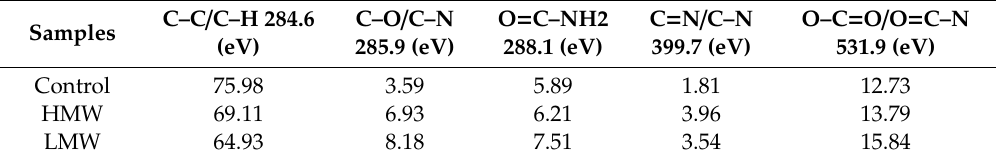
Table 3. Area (%) of the XPS spectra peaks for control sca ff olds and collagen sca ff olds with HMW and LMW chitosan.